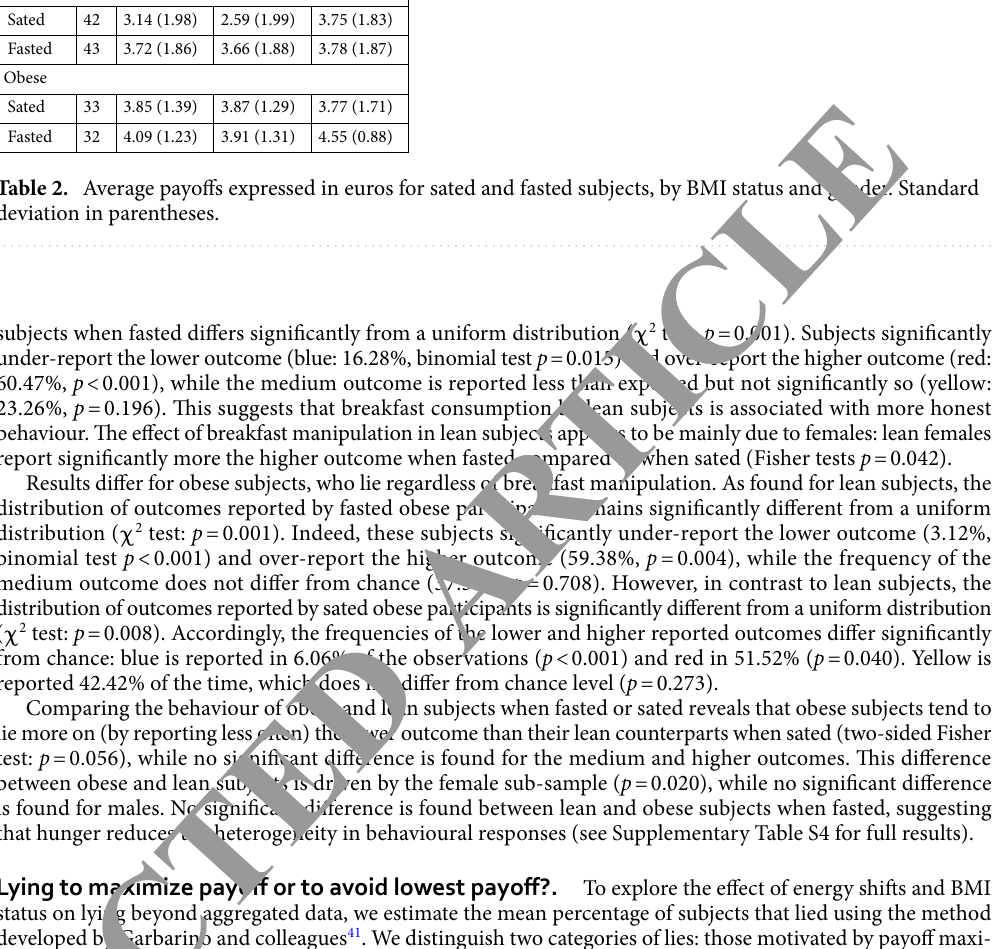
Sated: 28.52%) but not at 95% CI. For females this percentage goes from 36.25% when fasted to 5.32% when sated (95% CI lower bound in Fasted: 20.71%; upper bound in Sated: 18.57%, see Supplementary Fig. S3). The estimated percentage of lean liars motivated by the avoidance of the lowest outcome decreases more moderately with satiation, from 48.85% to 34.07%. This difference is not significant (see Fig. 2a); the same applies to females (see Supplementary Fig. S3). Since obese people lie in the same proportion both when sated and when fasted, there is no reason to expect